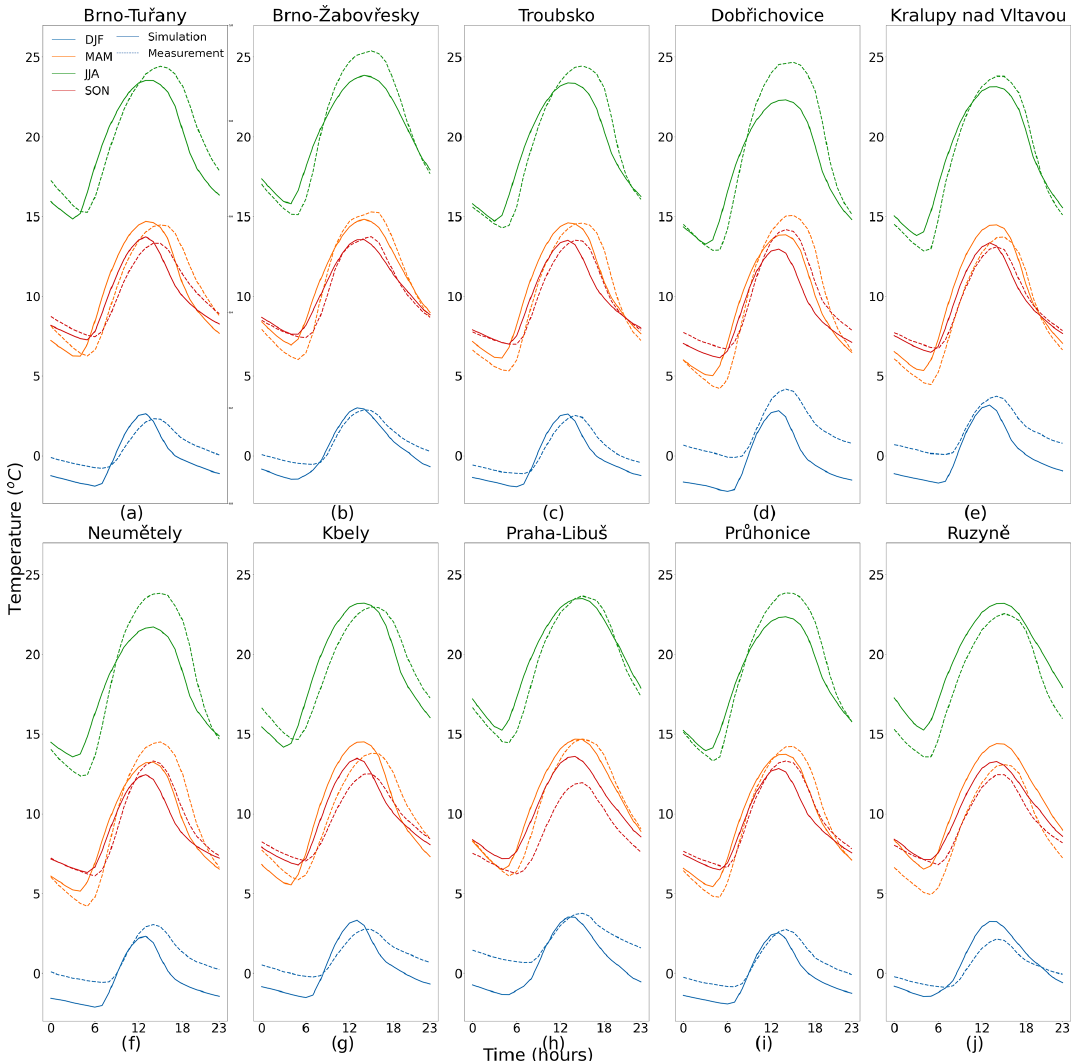
Figure 7. Comparison of modelled temperature diurnal profiles (solid) with measurements (dashed) from 10 Czech stations averaged over different seasons for the 2007–2016 period. Units in ◦